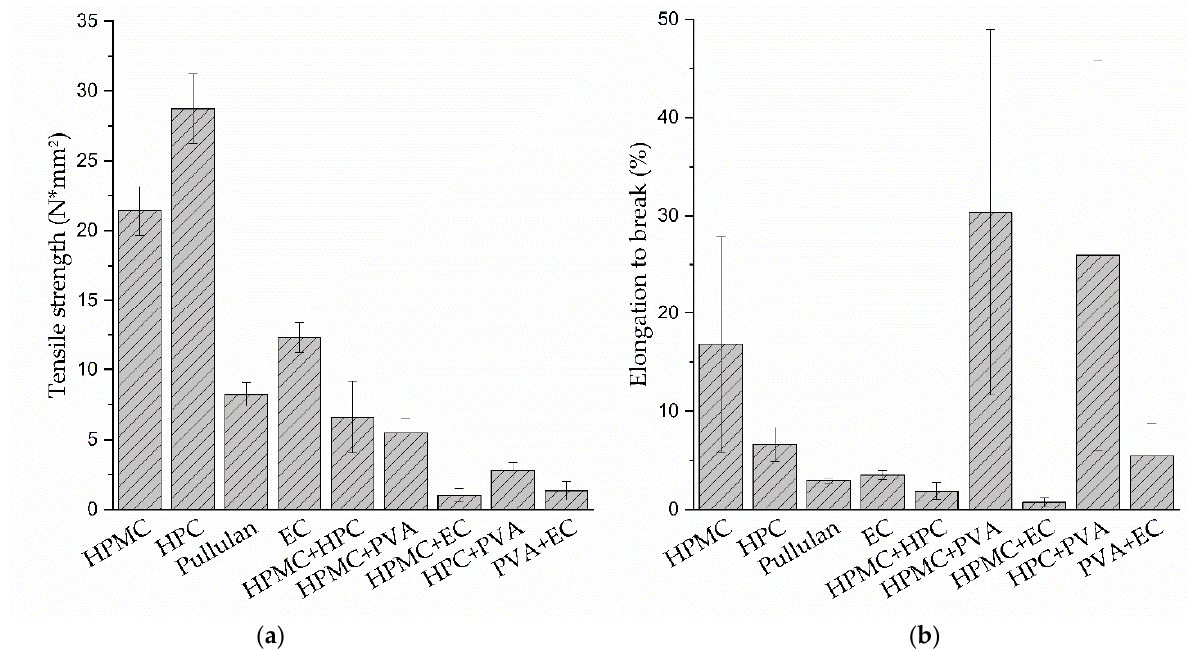
Figure 5. ( a ) Tensile strength and ( b ) elongation to break of the original formulations and the successfully prepared tandem films ( n = 6, mean ± sd). The PVA films did not rip until reaching the tensile tester´s maximum distance (elongation > 300%).